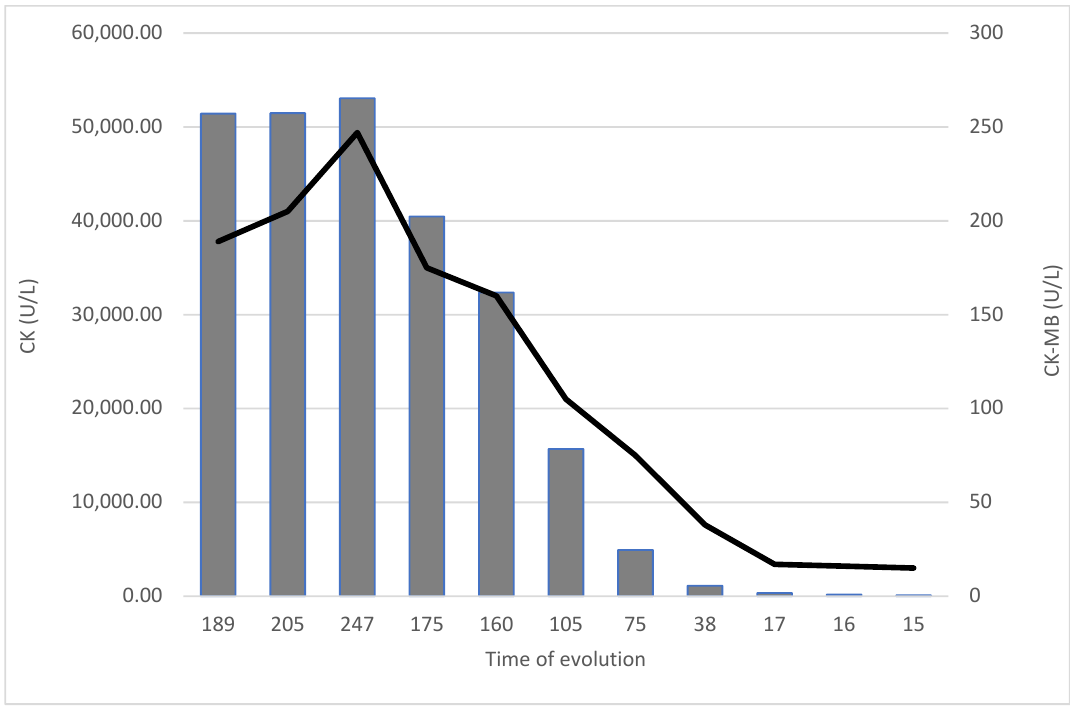
Figure 4. CK and CK-MB behavior during hospitalization. (CK, creatine phosphokinase; CK-MB, muscle-brain creatine phosphokinase isoenzyme).